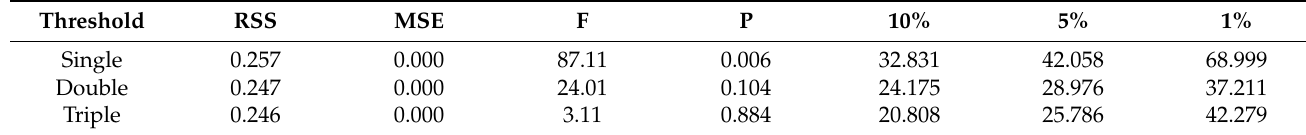
Table 4. Threshold effect test.